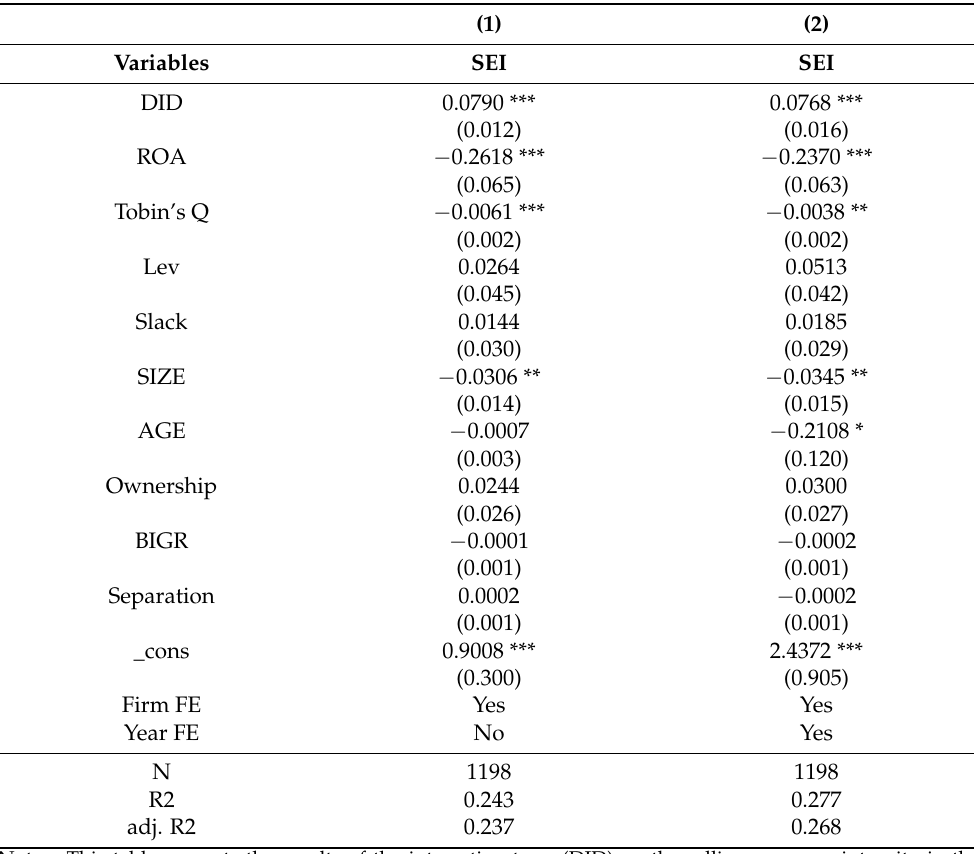
Table 8. Robust Test: Alternative dependent